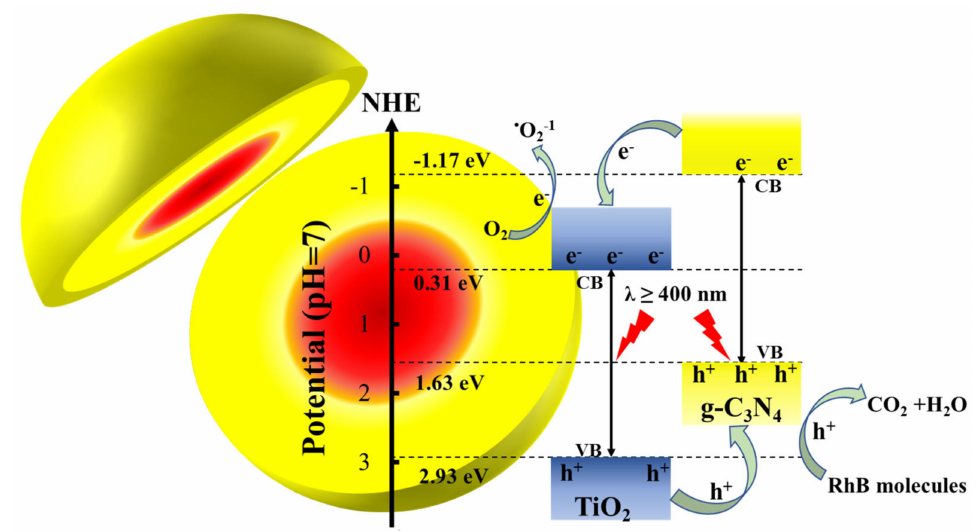
Figure 2. Photocatalytic mechanism scheme of TiO 2 − g − C 3 N 4 under visible light irradiation ( λ ≥ 400